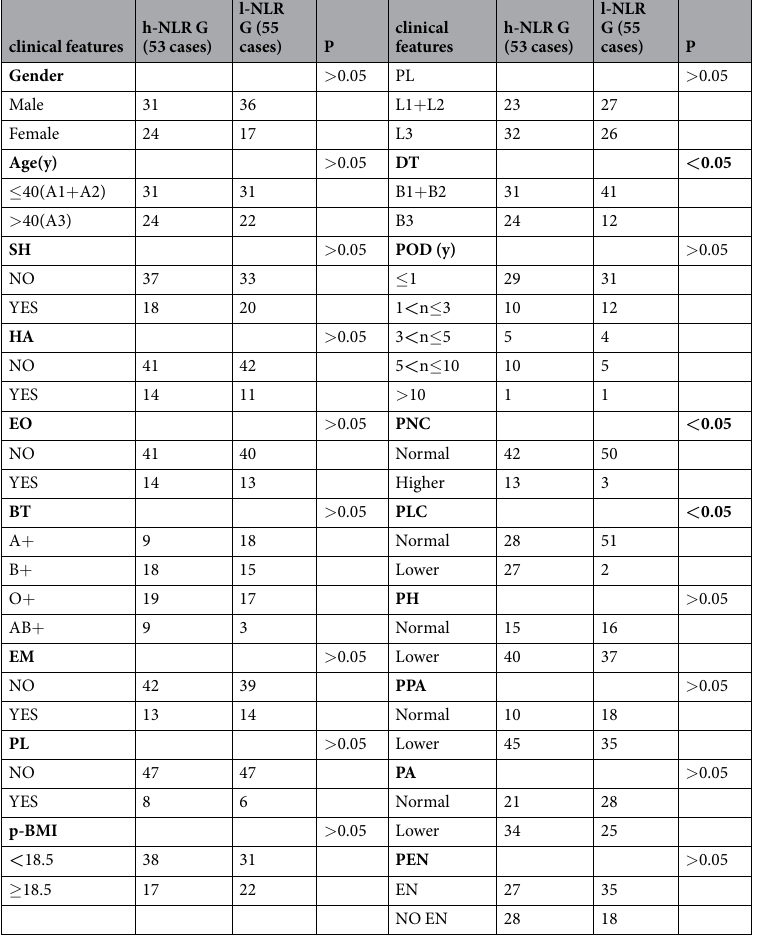
Table 6. Clinical features of the high NLR group (n = 55) versus the low NLR group (n = 53). h-NLR G , high NLR group; l-NLR G , low NLR group; SH , smoking history; HA , history of appendectomy; POD , preoperative duration; PL , primary lesion; DT , disease type (B3 or not); EM , extraintestinal manifestations; PL , perianal lesions; EO , emergency operation; p-BMI , preoperative BMI; BT , blood type; PH , preoperative haemoglobin; PNC , preoperative neutrophil count; PLC , preoperative lymphocyte count; PA , preoperative albumin; PPA , preoperative prealbumin; PEN , preoperative enteral nutrition.